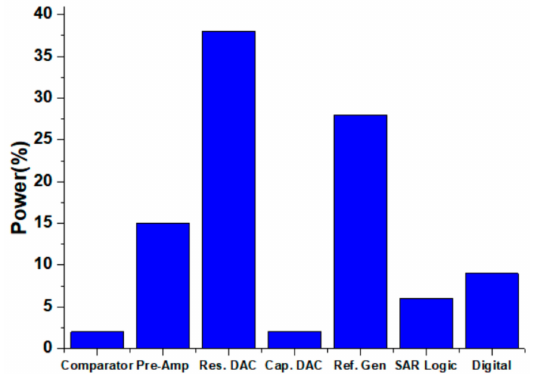
Figure 19. Power